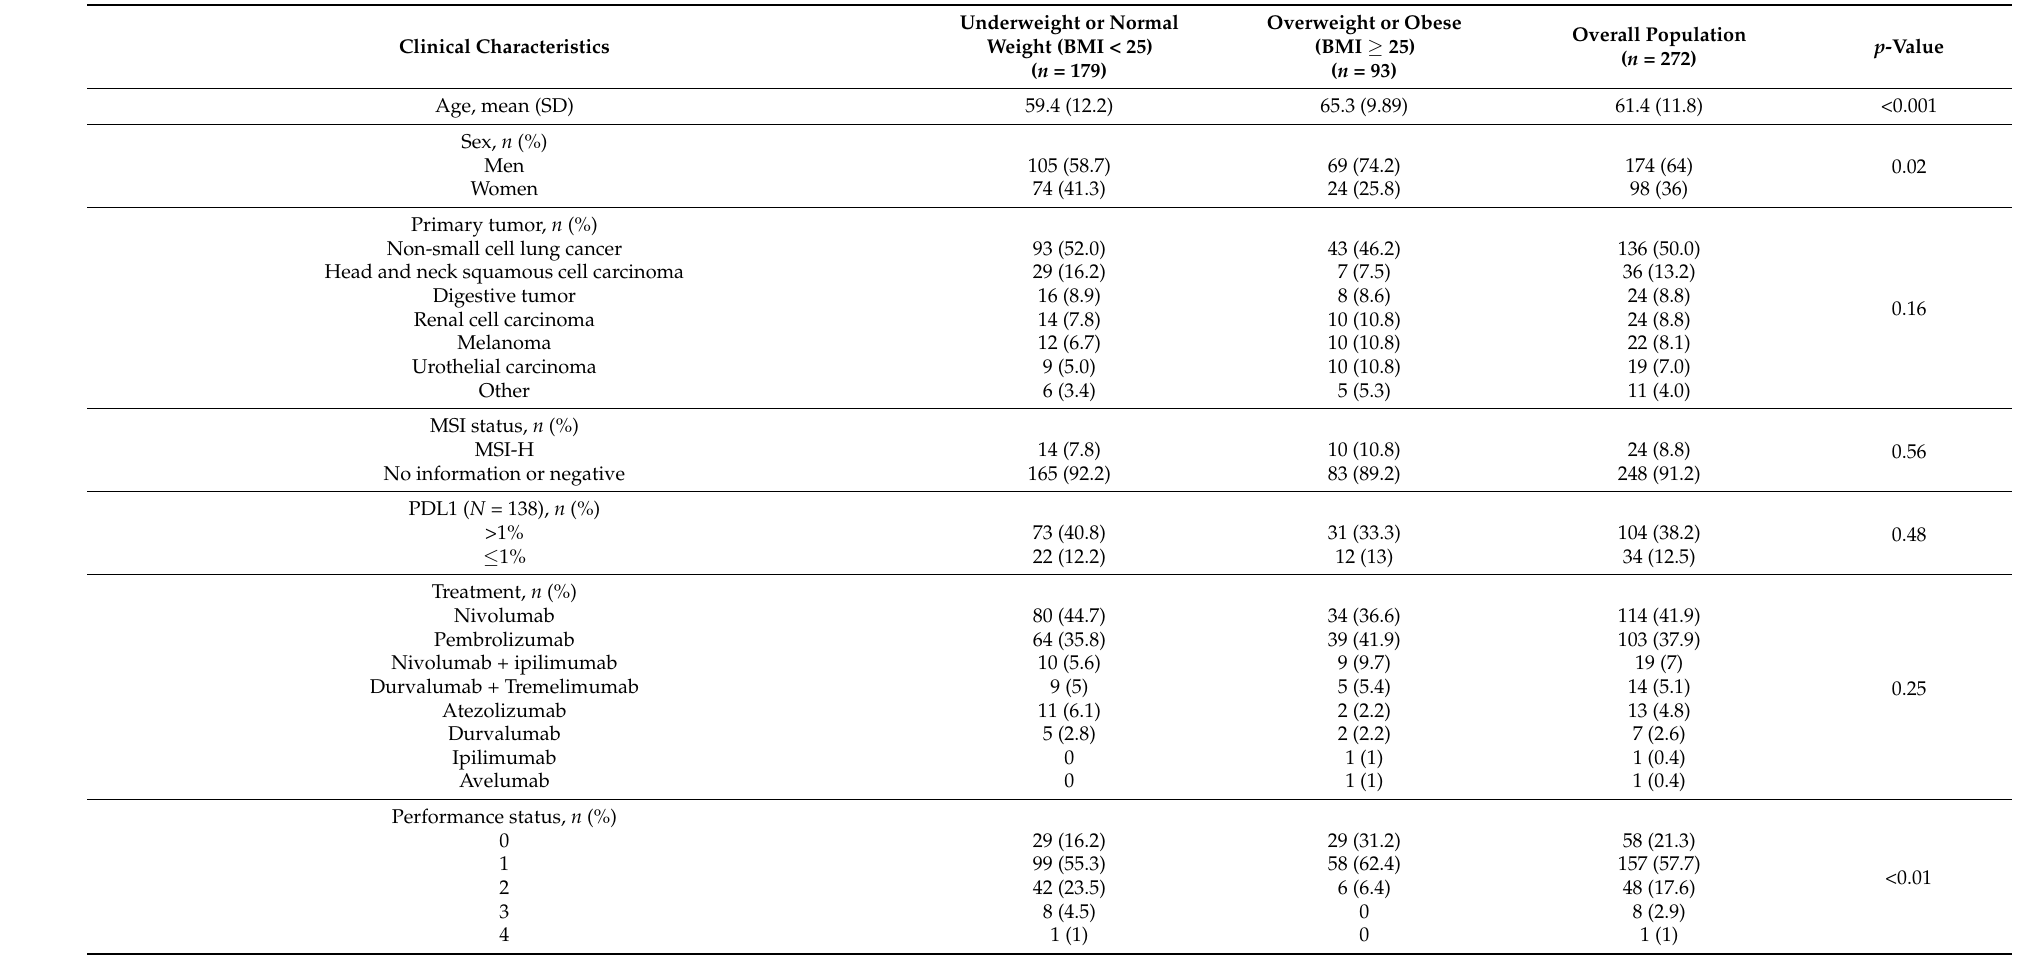
Table 1. Clinical and demographic characteristics: comparison of underweight and normal-weight patients (BMI > 25) with overweight and obese patients (BMI ≥ 25) ( n = 272). Clinical